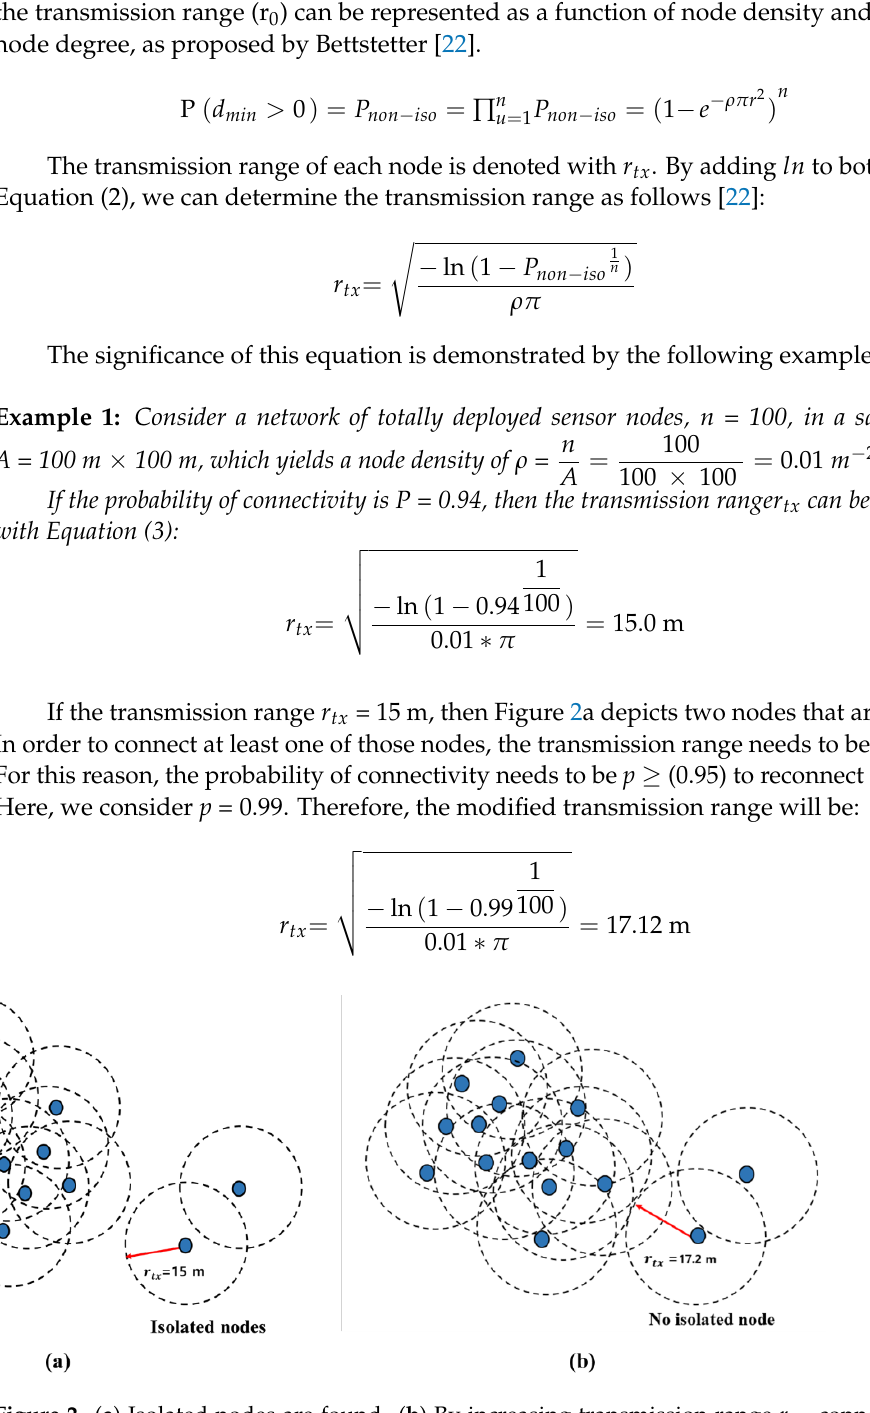
Table 1. The energy model’s parameters and their descriptions . Parameters